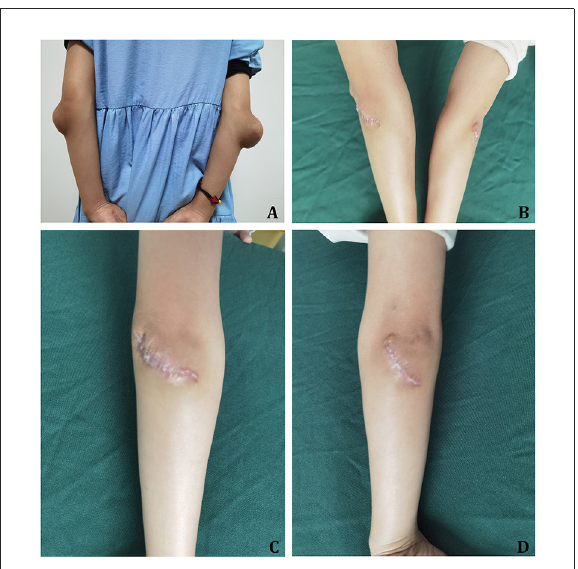
FIGURE3 Case 2. (A) Xanthoma in the bilateral elbow before the resection. (B–D) Three months after the resection of xanthoma at the bilateral